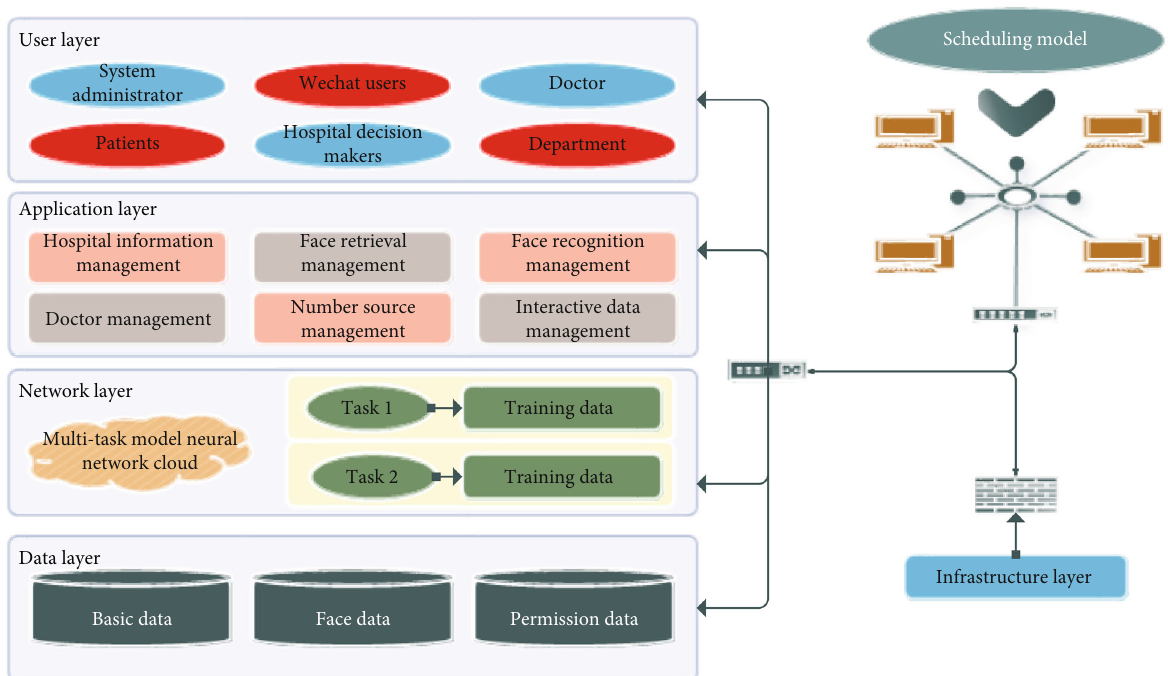
Figure 2: Overall system architecture diagram.